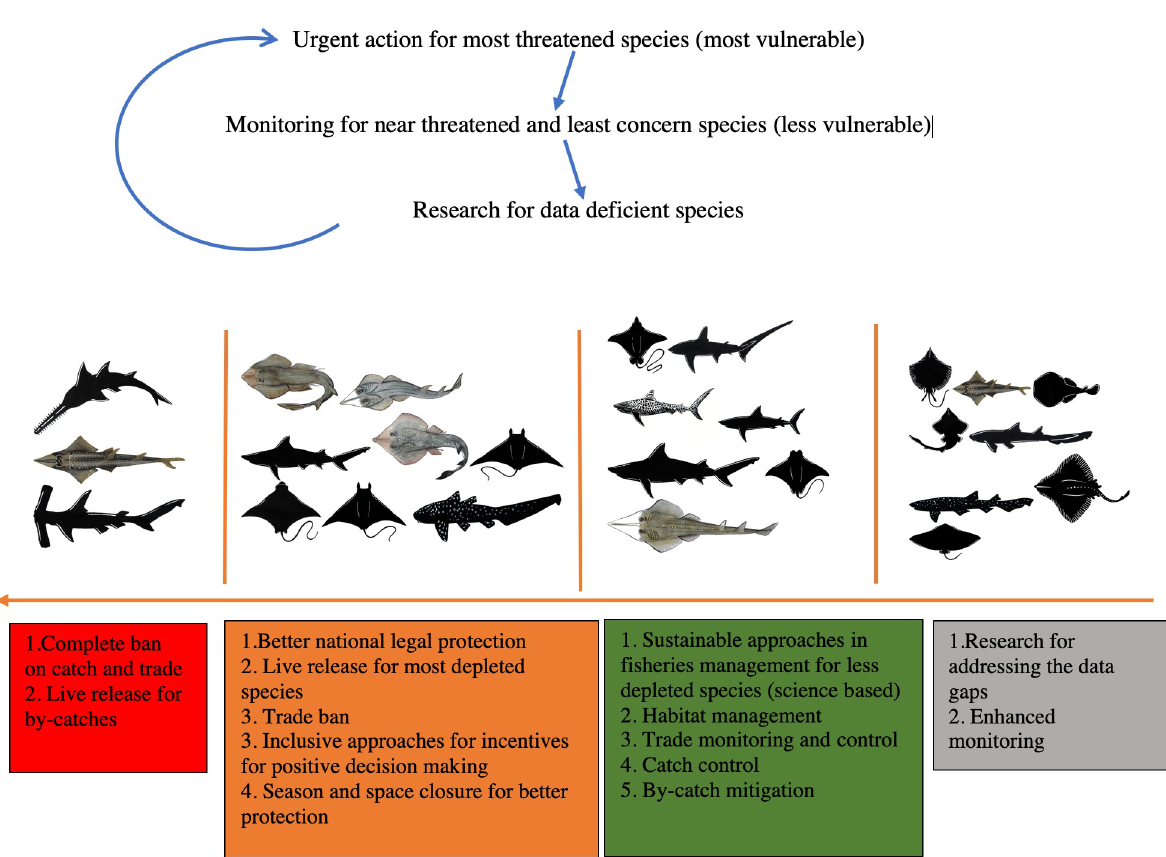
Fig 11. Specific conservation and research recommendations for different group of animals in accordance with their degree of threat.